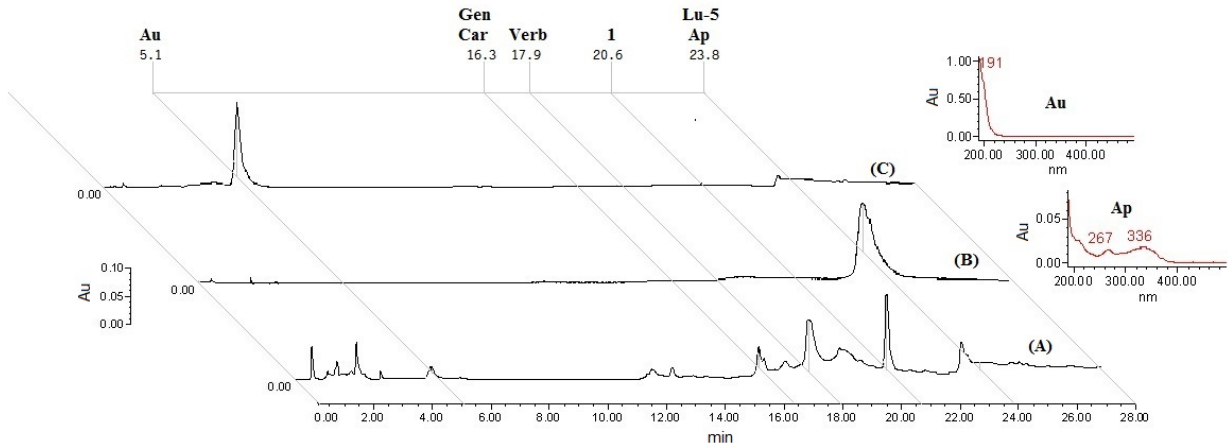
Figure 2. Chromatographic profiles of the methanol extract ( A ), apigenin reference ( B ), aucubin reference ( C ). Chromatograms were developed at the UV wavelength of 205 ( A , C ) and 340 ( B ) nm. The marked peaks (Rt = 5.1, 16.3, 17.9, 20.6 and 23.8 min) are assigned to aucubin ( Au ), geniposide ( Gen ), caryoptoside ( Car ), tenuifloroside ( 1 ), apigenin ( Ap ) and Luteolin 5-methyl ether ( Lu-5 ) respectively.